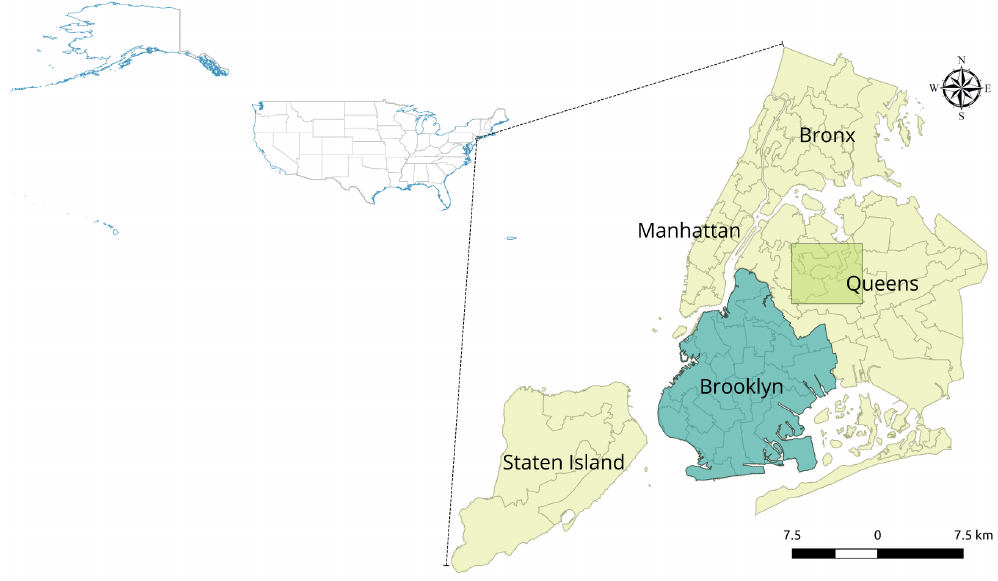
Figure 5. Overview of the study area in New York City, the